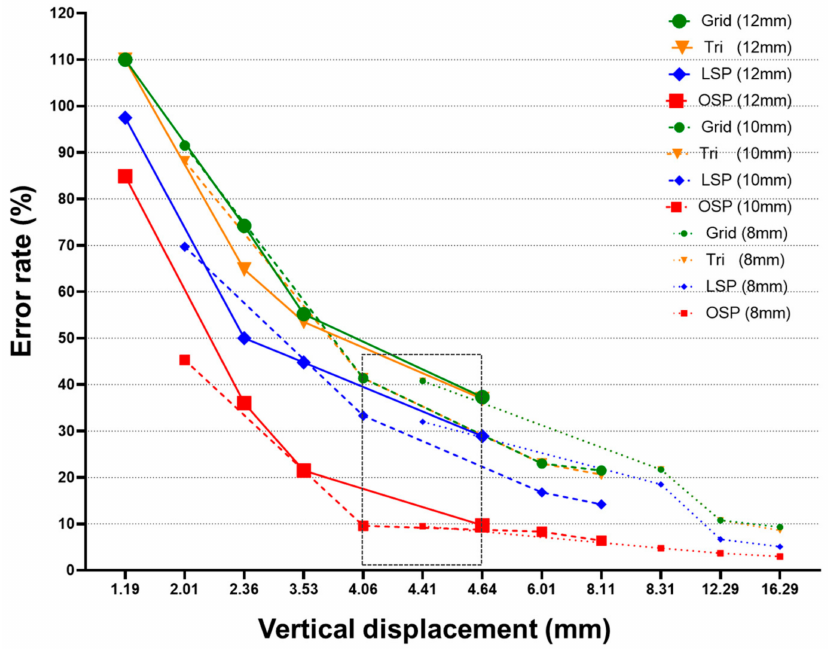
Figure 16. Comparison of error rates for vertical displacement of three specimens based on